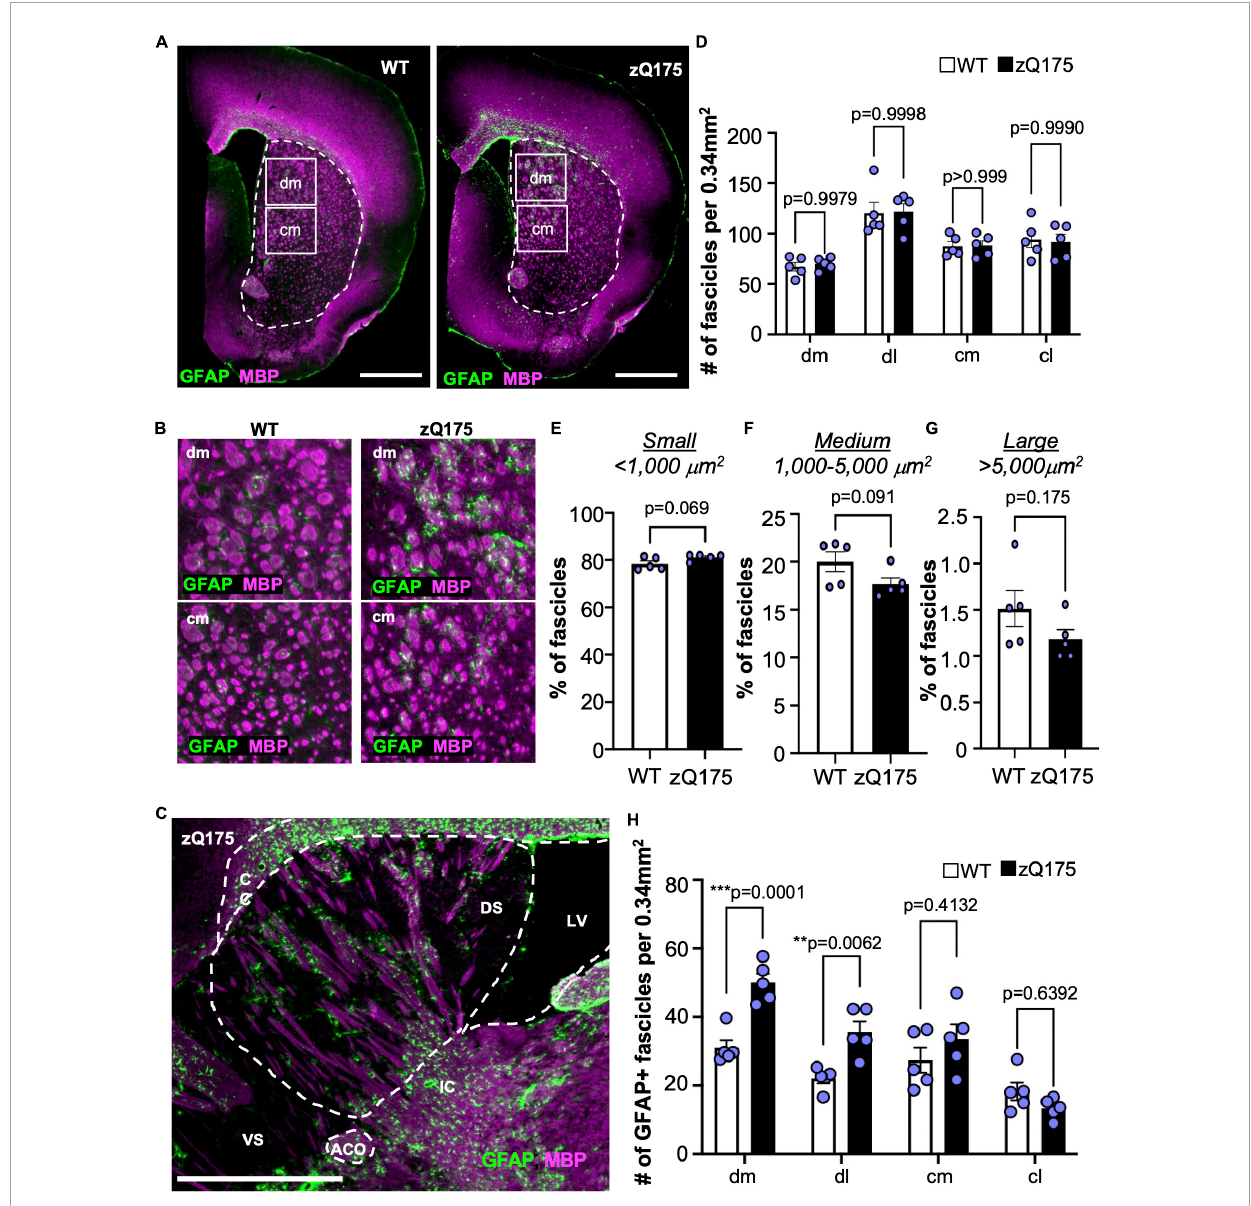
FIGURE5 GFAP + astrocytes are associated with WM fascicles in the dm striatum. (A) GFAP and MBP immunofluorescence in coronal brain sections from 18-month-old WT and zQ175 mice. The striatum is shown with a dotted line. Scale bar is 1 mm. (B) Zoomed images from the dm (upper panel) and cm (lower panel) regions of the striatum from images in (A) . (C) Immunofluorescence of a sagittal brain section from an 18-month-old zQ175 mouse costained with GFAP and MBP. Corpus callosum (CC), dorsal striatum (DS), ventral striatum (VS), lateral ventricle (LV), and anterior commissure (ACO). Scale bar is 1 mm. (D) Number of fascicles per 0.34 mm 2 in striatal regions of 18-month-old WT and zQ175 mice. Percent of WM fascicles in the striatum with a cross-sectional area lower than 1,000 µ m 2 [small– (E) ], 1,000–5,000 µ m 2 [medium– (F) ], or greater than 5,000 µ m 2 [large– (G) ] in 18-month-old WT and zQ175 mice. (H) Number of GFAP + fascicles per 0.34 mm 2 in striatal regions 18-month-old WT and zQ175 mice. Whole striatum values were calculated as the average of all four striatum regions. All experiments were carried out with n = 5 mice/genotype and all analysis was done using confocal images. Two-way ANOVA with Sidak’s multiple comparisons [ (D) Interaction: F = 0.04568, df = 3; striatal region: F = 20.06, df = 3; genotype: F = 0.01802, df = 1. (H) Interaction: F = 6.900, df = 3; striatal region: F = 26.67, df = 3; genotype: F = 18.61, df = 1] and un-paired student’s t -tests [ (E) t = 2.098, df = 8; (F) t = 1.922, df = 8; (G) t = 1.488, df = 8]. For two-way ANOVAs, only p -values for comparisons between WT and zQ175 are shown. Error bars denote mean ± SEM. ** p < 0.01, *** p < 0.001.